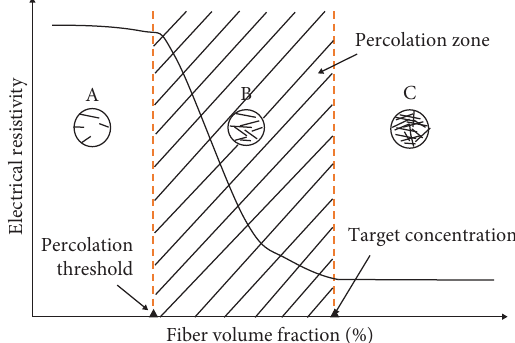
Figure 1: Variation of the electrical resistivity with the